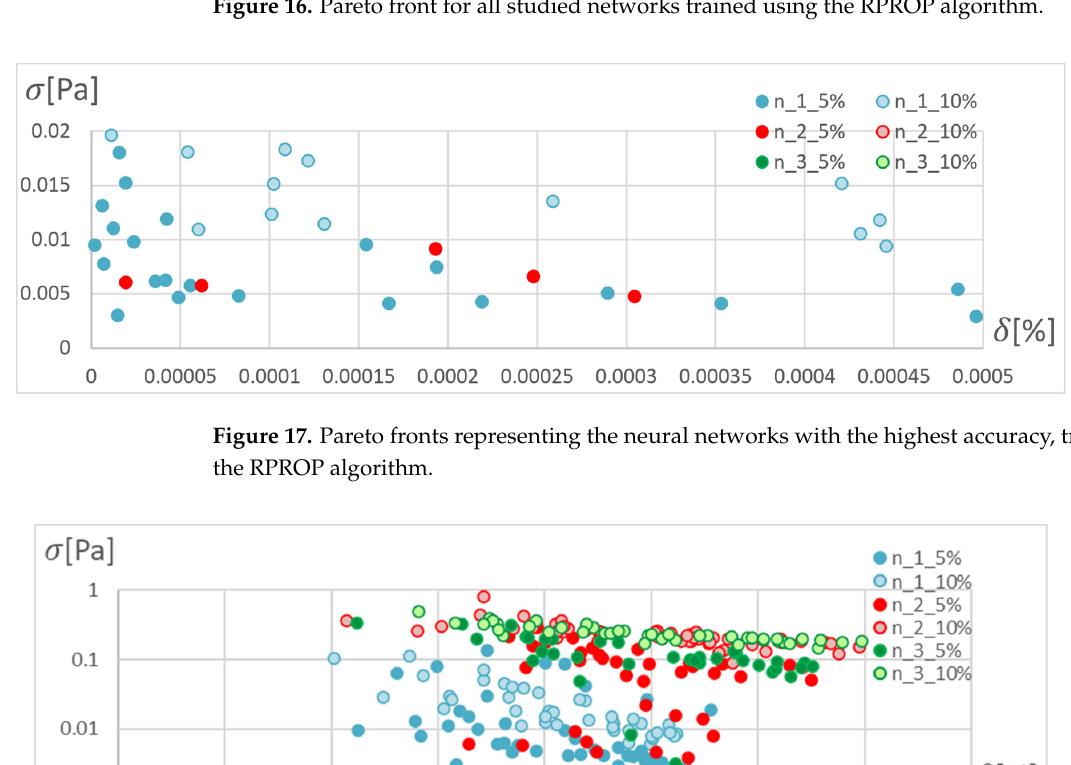
Figure 18. Pareto fronts presented on a logarithmic scalefor all studied networks trained using the RPROP algorithm.